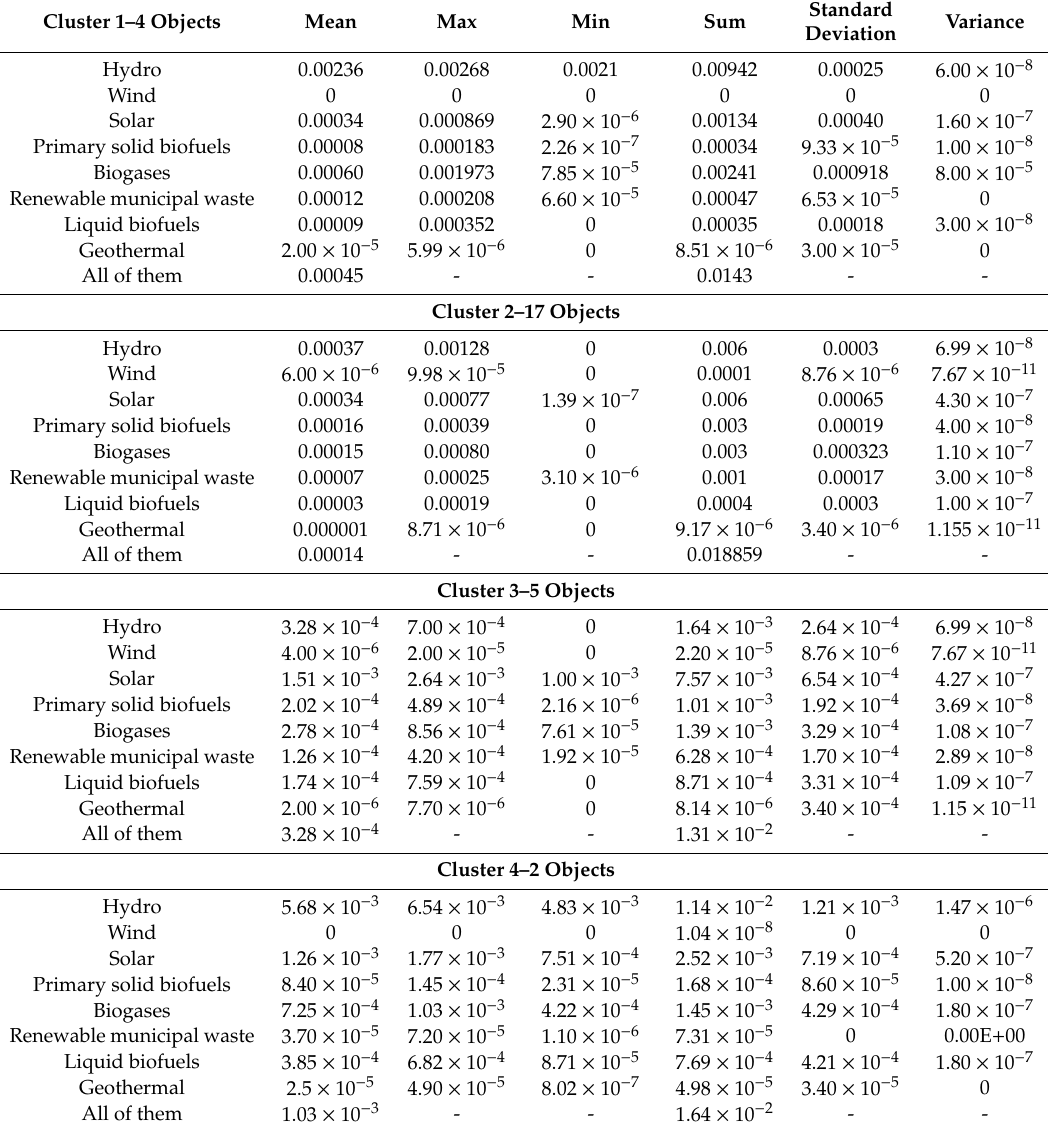
Table 21. Elements of clusters with distances from centers (own